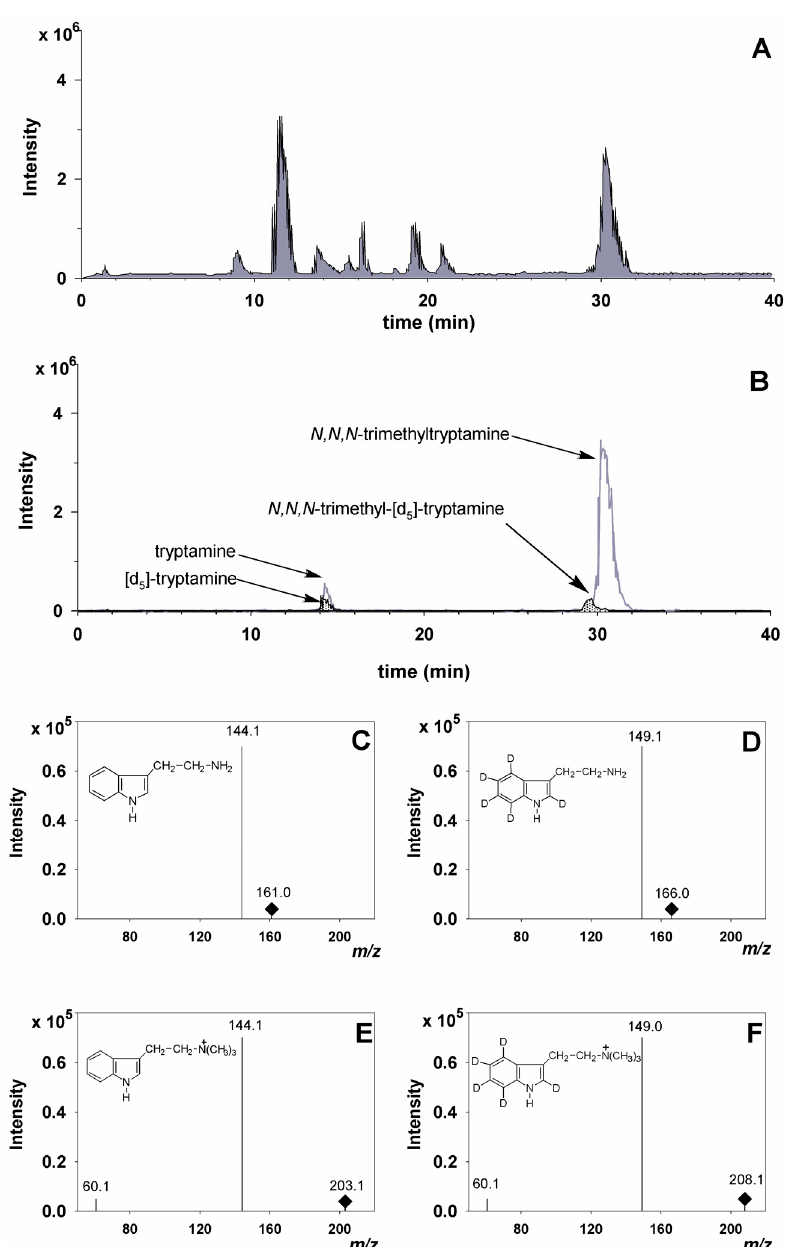
Figure 1. Distribution of tryptamine and its N -methyl derivative in an extract of lemon seedlings grown in the presence of [d 5 ]Trp: ( A ) total ion current (TIC) chromatogram; ( B ) extracted ion chromatogram (EIC) in positive multiple reaction monitoring (MRM) using the following precursor to product ion transitions: 161.1 → 144, 175.1 → 144, 189.1 → 144, 203.1 → 144, 166.1 → 149, 180.1 → 149, 194.1 → 149, 208.1 → 149. Only EIC peaks at 161.1 → 144, corresponding to tryptamine, 166.1 → 149, corresponding to [d 5 ]tryptamine, 203.1 → 144, corresponding to N , N , N -trimethyltryptamine, and 208.1 → 149, corresponding to [d 5 ] N , N , N -trimethyltryptamine, were detected; ( C ) fragmentation pattern of the EIC peak at 161.1 → 144, corresponding to tryptamine; ( D ) fragmentation pattern of the EIC peak at 166.1 → 149, corresponding to [d 5 ]tryptamine; ( E ) fragmentation pattern of the EIC peak at 203.1 → 144, corresponding to N , N , N -trimethyltryptamine; and ( F ) fragmentation pattern of the EIC peak at 208.1 → 149, corresponding to [d 5 ] N , N , N -trimethyltryptamine.